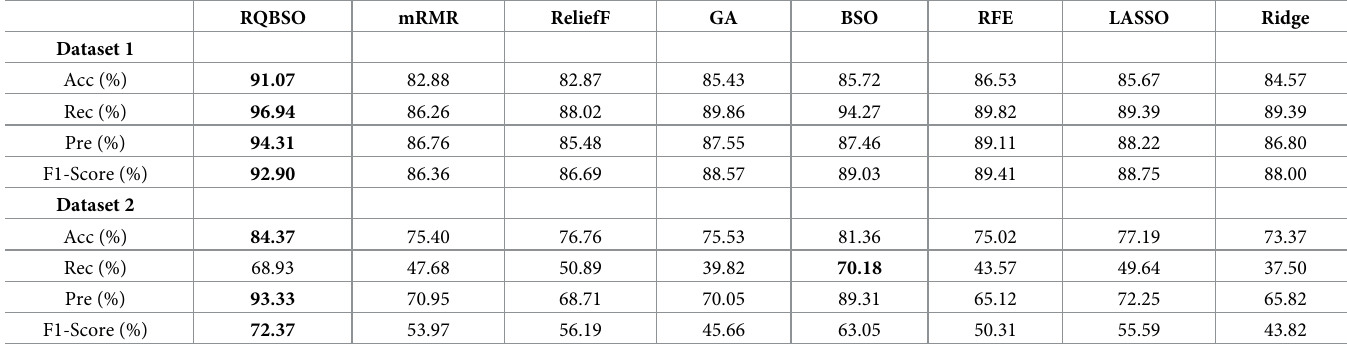
Table 4. The performance comparison of different feature selection models.